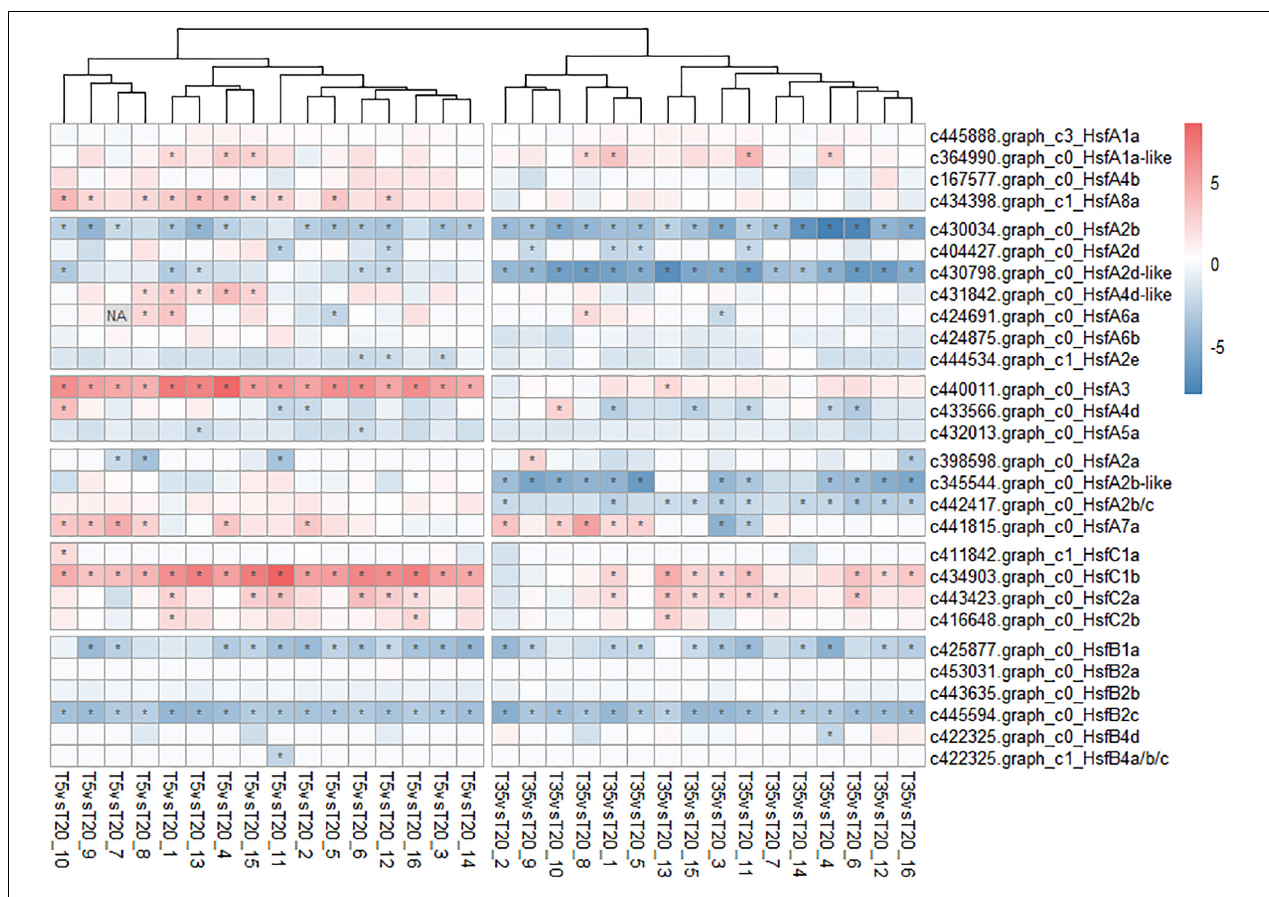
FIGURE 7 | Heatmap of the heat shock transcription factors (Hsfs) genes associated with temperature response in bermudagrass. The abundance (FPKM) of T20 treatment is the reference and the relative expression was determined by the log2 (T5 or T30 _ fragments per kilobase of transcript per million mapped reads [FPKM]/T20_FPKM). The asterisk (*) in the block indicates significant difference ( p < 0.05) of